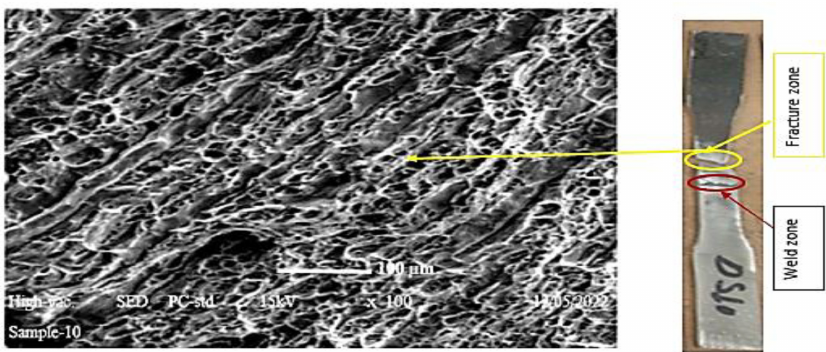
Figure 17. Tensile fracture surface obtained in the base metal of 316 stainless steel.